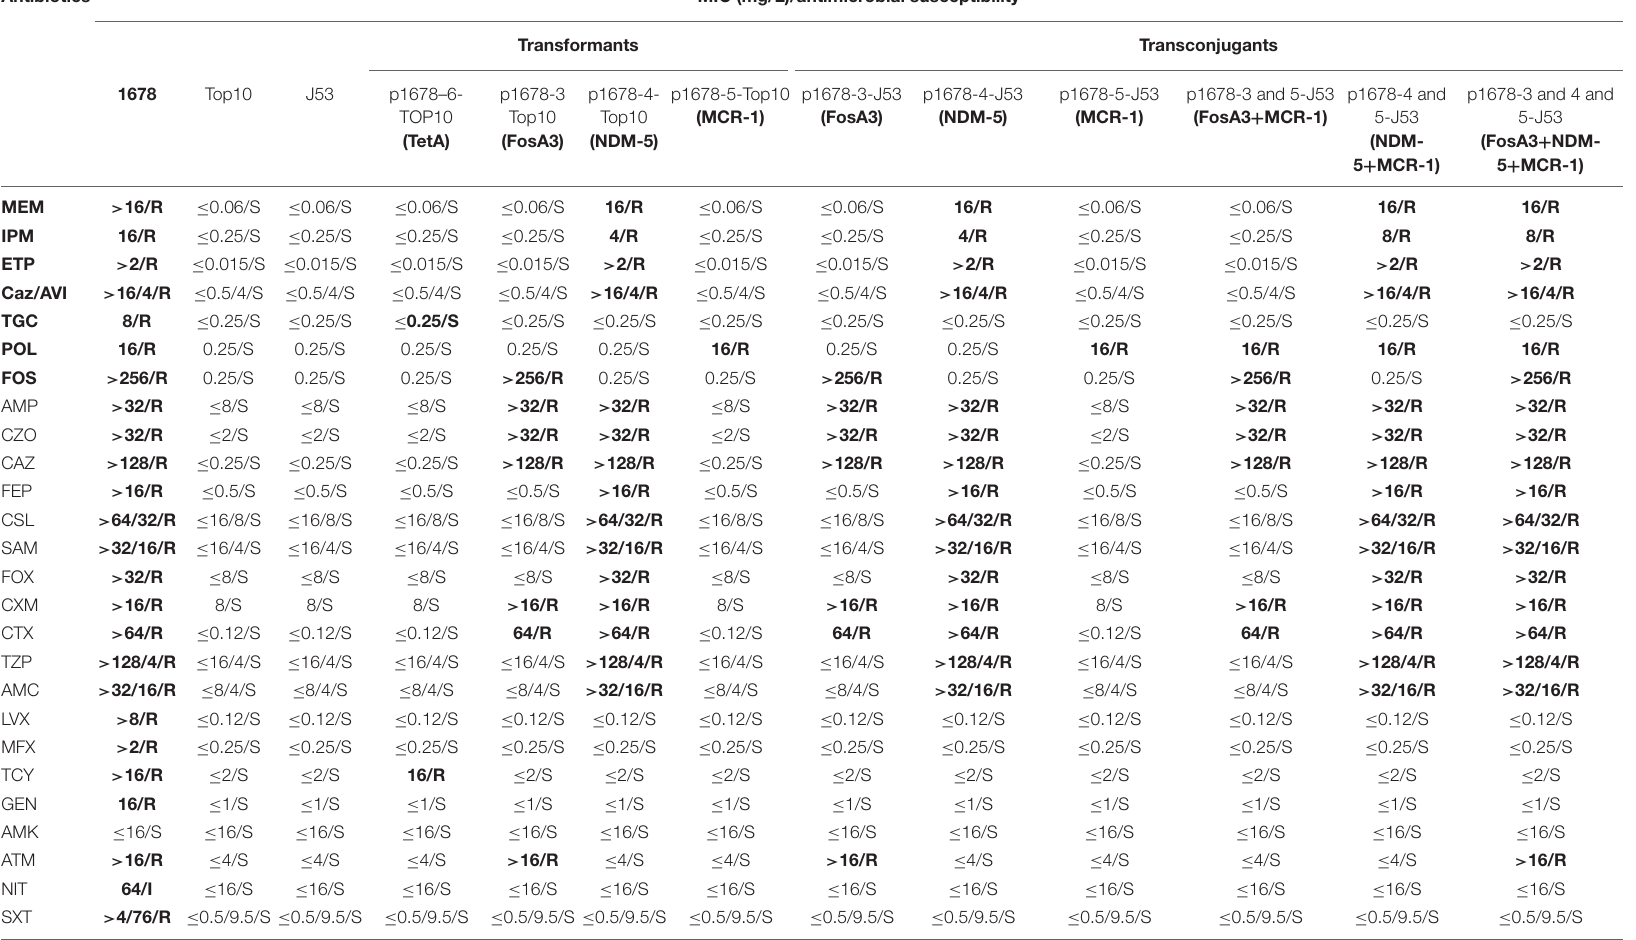
TABLE 1 | Antimicrobial drug susceptibility profiles.